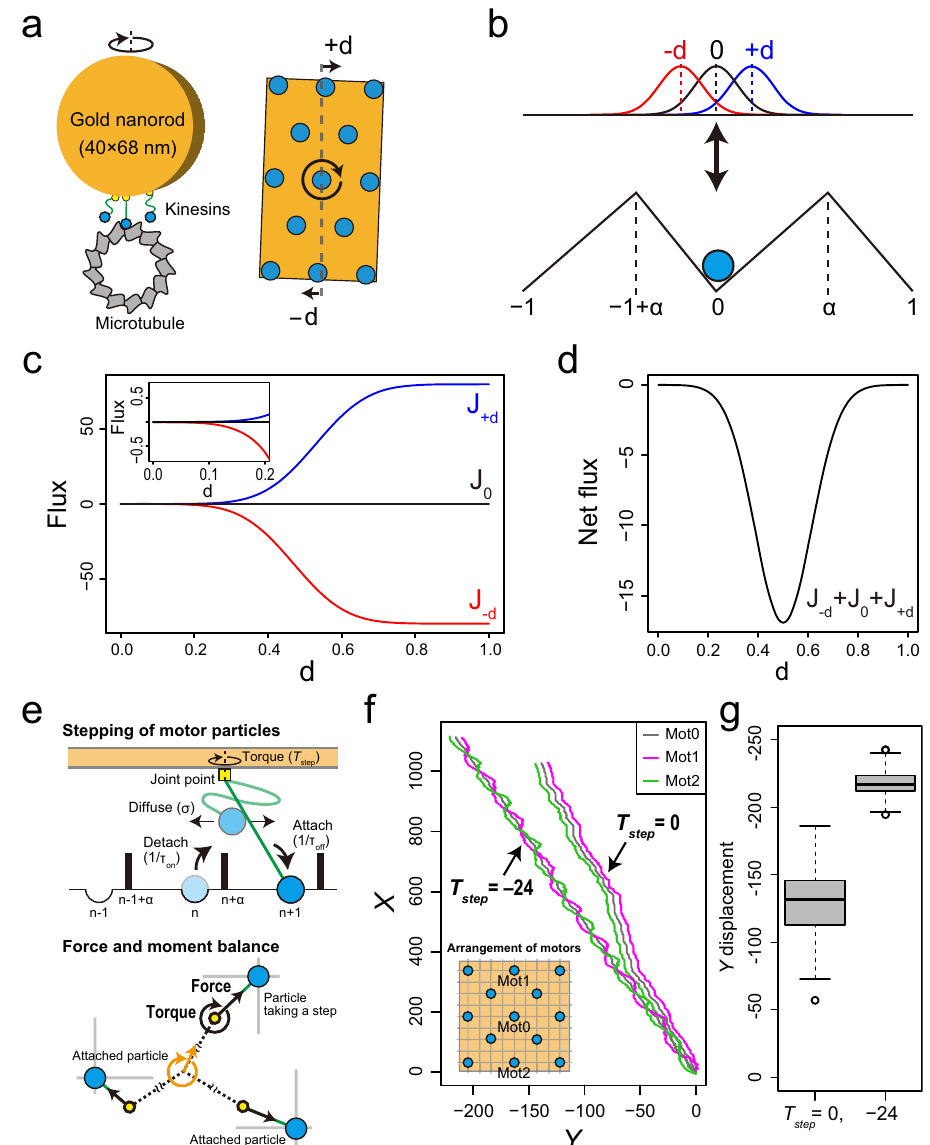
Fig. 7 Mechanistic model for the yawing and helical motion of kinesin-coated gold nanorods (GNRs). a By rotation of the GNR, motors in the posterior and anterior positions relative to the rotation axis move laterally with displacement of ± d . b This situation can be modeled using the noise-driven ratchet model with asymmetry potentials ( α ) and three different starting positions of the particles ( − d , 0, + d ). c , d Fluxes of three particles at the starting positions of diffusion in the noise-driven ratchet with asymmetry potentials after 1/ γ units of time (Materials and Methods). c Fluxes of three particles, J − d , J 0 , and J + d as a function of d with α = 0.53 and γ = 160 s − 1 . d Net fl ux, J − d + J + J + d as a function of d . e – g 2D Monte Carlo simulation of 13 motor particles 0 without and with torque generation ( T step = 0 and − 24, respectively). e Schematic description of the model. f Typical X-Y -trajectories of the forward, and center, and backward particles (magenta, gray, and green lines, respectively) represent biased forward, sideward and rotational motions of the cargo. g Box plot of comparison of lateral displacements without and with torque generation. The box represents the 75-25th percentiles, and the median is indicated as black line ( n = 300 simulations). The circle sign represents an